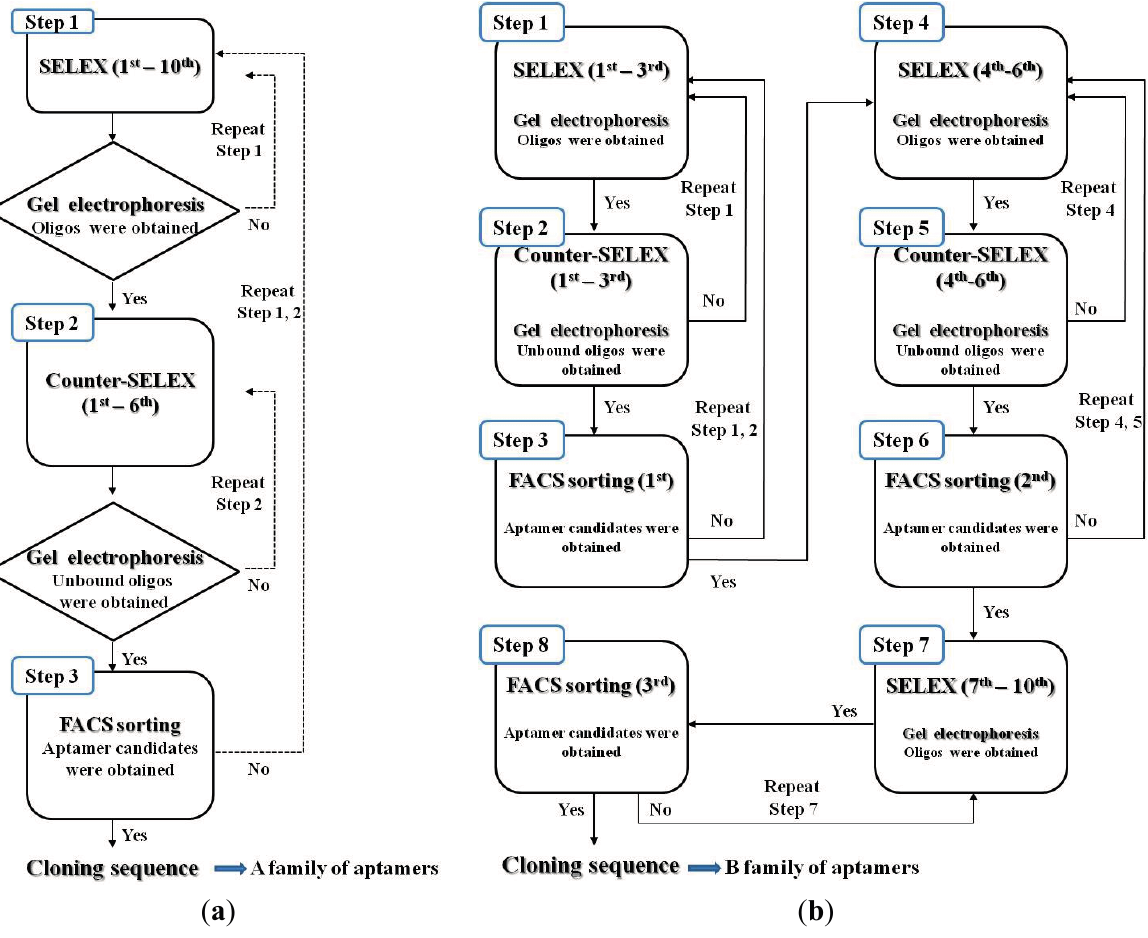
Figure 1. ( a ) Schematic diagram of the basic whole-cell SELEX procedures used to isolate DNA aptamers with high binding affinity for Staphylococcus aureus ; ( b ) Schematic diagram of the modified whole-cell SELEX process used to isolate DNA aptamers with a high binding affinity for Staphylococcus aureus